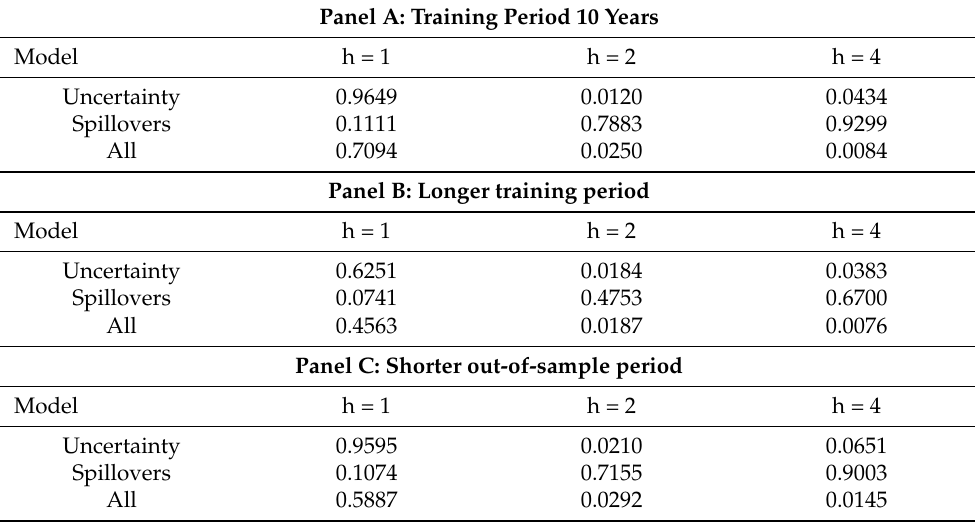
Table 5. Forecasting results for ln RV